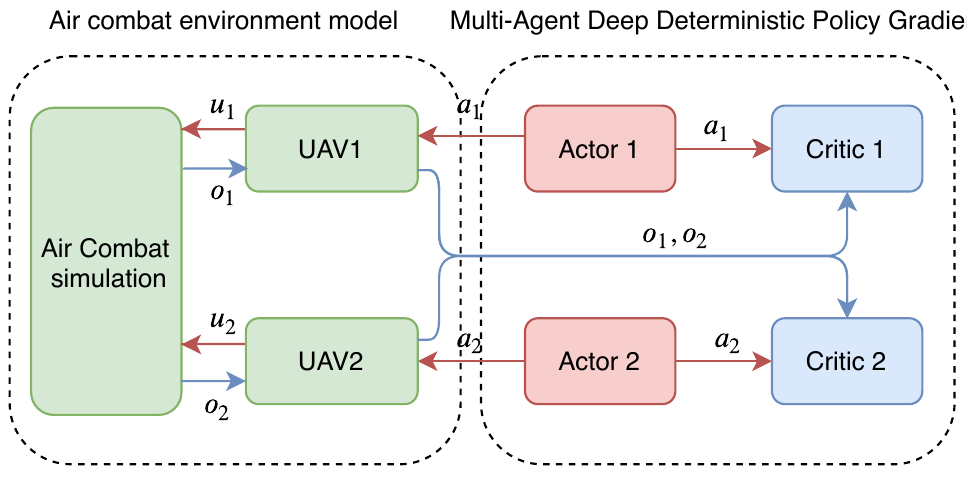
Figure 1. The schematic diagram of MADDPG’s “centralized training, distribution